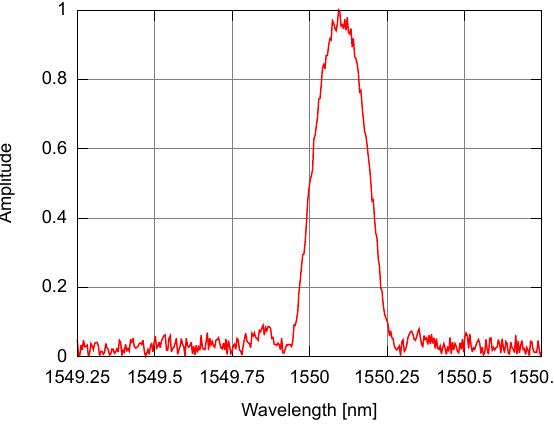
Figure 3. Example of optical spectrum for an FBG with uniform modulation index profile and AWGN.